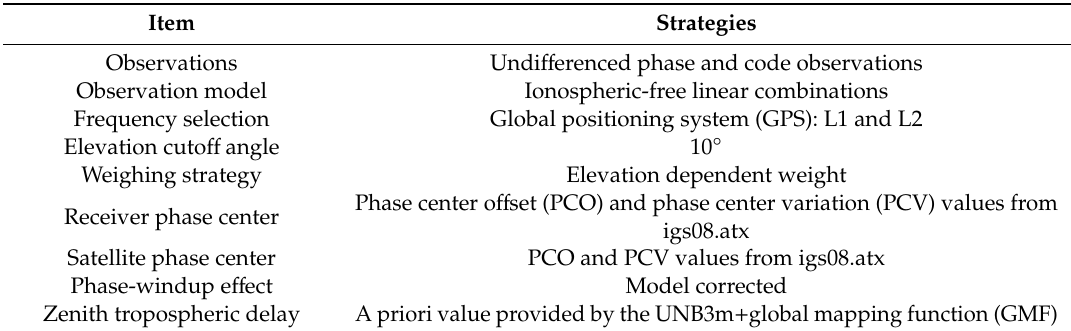
Table 2. Data processing strategies of